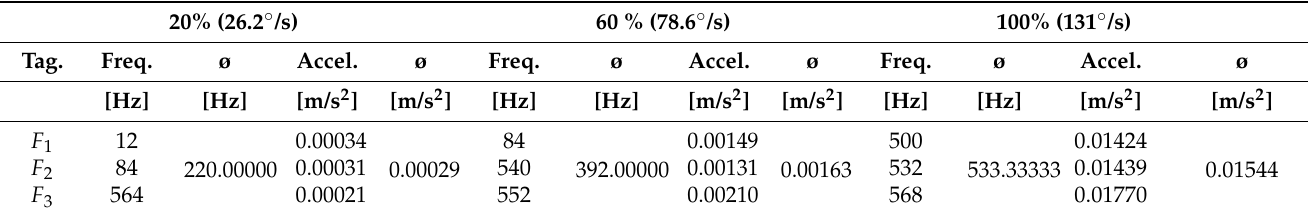
Table 8. Evaluated measured values of frequency and acceleration in Z -axis for each